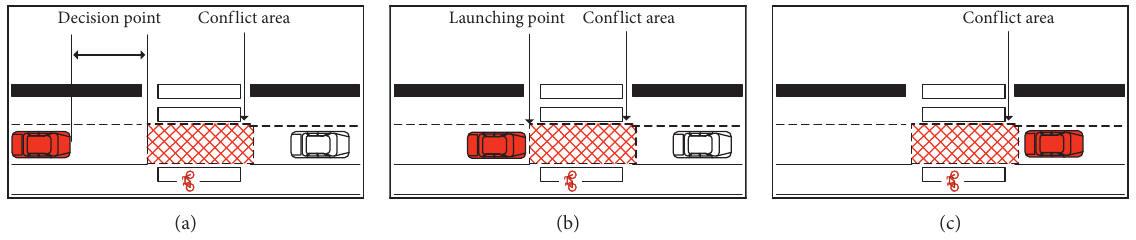
Figure 2: Schematic diagram of vehicles passing bicycles at